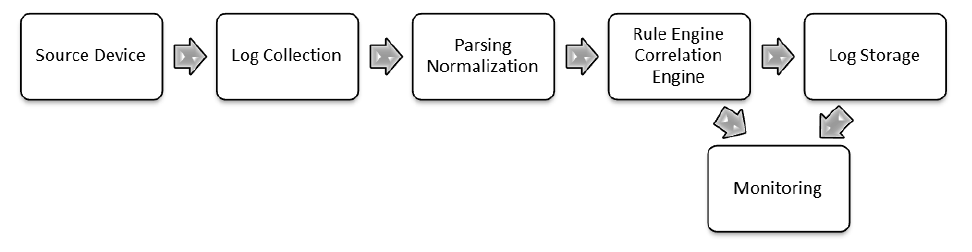
Figure 1. SIEM basic